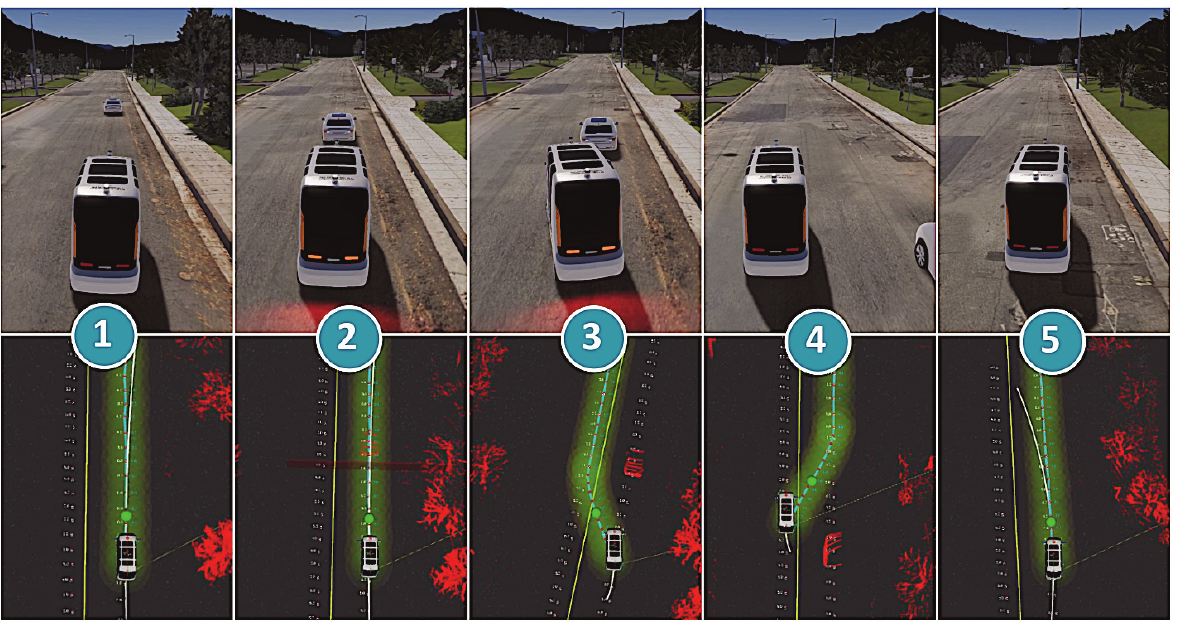
Fig. 9. Five different steps of the scenario A simulation in the SVL simulator (top) and in the Rviz (bottom).